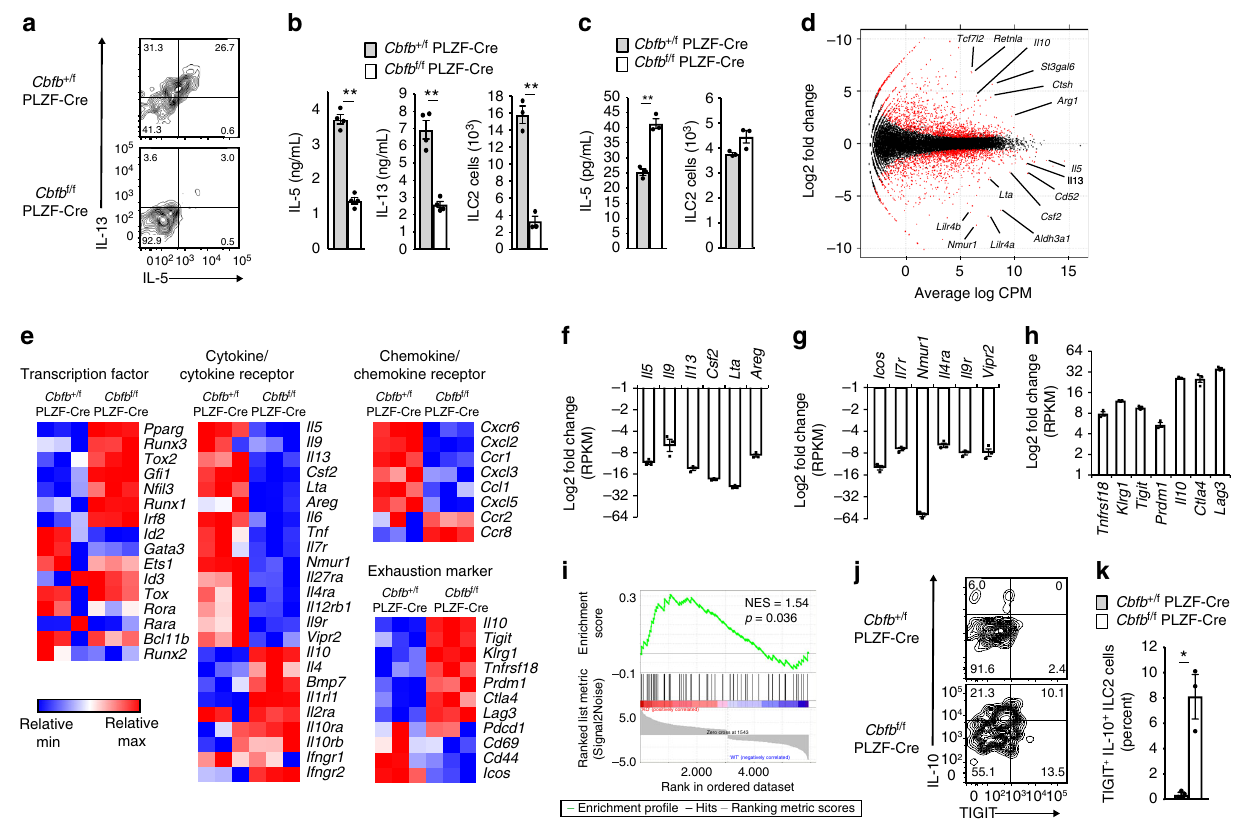
Fig. 4 Cbf β -de fi cient ILC2s show an exhausted-like phenotype after cytokine stimulation. ILC2s (CD45 + CD3 – CD19 – CD127 + CD25 + ST2 + KLRG1 + ) were sorted from the lungs of Cbfb + /f PLZF-Cre or Cbfb f/f PLZF-Cre mice and cultured with IL-2 and IL-33 ( a , b , d – k ) or IL-2 and IL-7 ( c ). The number of days is indicated below. a Flow cytometry analysis of IL-5 and IL-13 expression by ILC2s from the indicated mice cultured for 3 days. b , c The IL-5 ( b , left; c , left) and IL-13 ( b , middle) concentrations in the culture supernatants from the indicated mouse ILC2s on day 4 and the absolute number of cultured ILC2s ( b , right; c , right) from the indicated mice on day 6. d MA plots of genes expressed in Cbfb f/f PLZF-Cre ILC2s versus Cbfb + /f PLZF-Cre ILC2s cultured with IL-5 and IL-13 for 4 days. Red dots indicate genes that were signi fi cantly differentially expressed (false discovery rate < 0.05). e Heat map of selected genes expressed in the cultured Cbfb f/f PLZF-Cre ILC2s versus Cbfb + /f PLZF-Cre ILC2s ( e ). f , g , h Mean fold change of RPKM values of the indicated genes in Cbfb f/f PLZF-Cre ILC2s versus Cbfb + /f PLZF-Cre ILC2s. i Gene set enrichment analysis of signature genes observed in exhausted CD8 + T cells performed on a gene set that was differentially expressed in Cbfb f/f PLZF-Cre ILC2s stimulated with IL-33 in vitro compared to Cbfb + /f PLZF-Cre ILC2s. j Flow cytometry analysis of TIGIT and IL-10 expression by cultured ILC2s from the indicated mice on day 6. k The frequency of TIGIT + IL-10 + cells in the indicated ILC2s was determined by fl ow cytometry as in j . Numbers indicate the percentages of cells in each quadrant ( a , j ). In b , c , k , * p < 0.05 and ** p < 0.01 by Student ’ s t -test. Data are representative of at least two independent experiments (mean ± s.d. of four mice in b , c and of three mice in k (Supplementary Fig. 5a, b). Neutralization of IL-10 did not cancel the low reactivity of the Cbfb f/f PLZF-Cre ILC2s against IL- show reduced expression in the absence of Cbf β (Fig. 4e, g). In 33 (Supplementary Fig. 5c). In addition, our RNA sequence analysis showed that the expression levels of TIGIT ligands, such as CD112 and CD155, were quite low in ILC2s; the RPKM values (Fig. 4e, h) 14 . Gene set enrichment analysis indicated that Cbf β - de fi cient ILC2s stimulated with IL-33 had a signature of exhausted CD8 + T cells (Fig. 4i). Since the TIGIT and IL-10 expression levels were low in the control ILC2s, we thought that upregulation of TIGIT and IL-10 might be good marker for this hyporesponsiveness and con fi rmed the elevated expression of the IL-10 and TIGIT proteins in activated-ILC2s lacking Cbf β in vitro (Fig. 4j, k). Collectively, ILC2s present in the lungs of the Cbfb f/f PLZF-Cre mice show hyporesponsiveness to cytokine stimulation in vitro and acquire unique gene expression signatures similar to those observed in exhausted T cells.